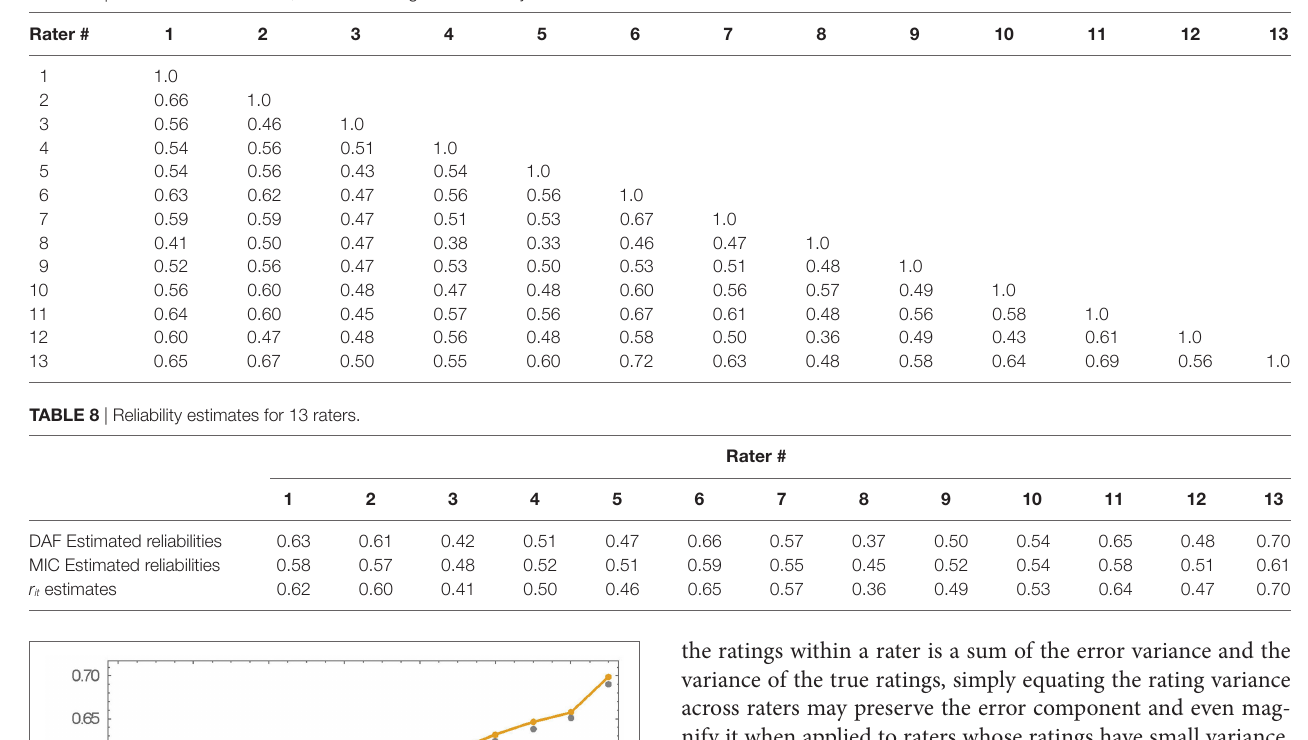
TaBle 7 | Raters’ intercorrelations, based on ratings of 250 essays.